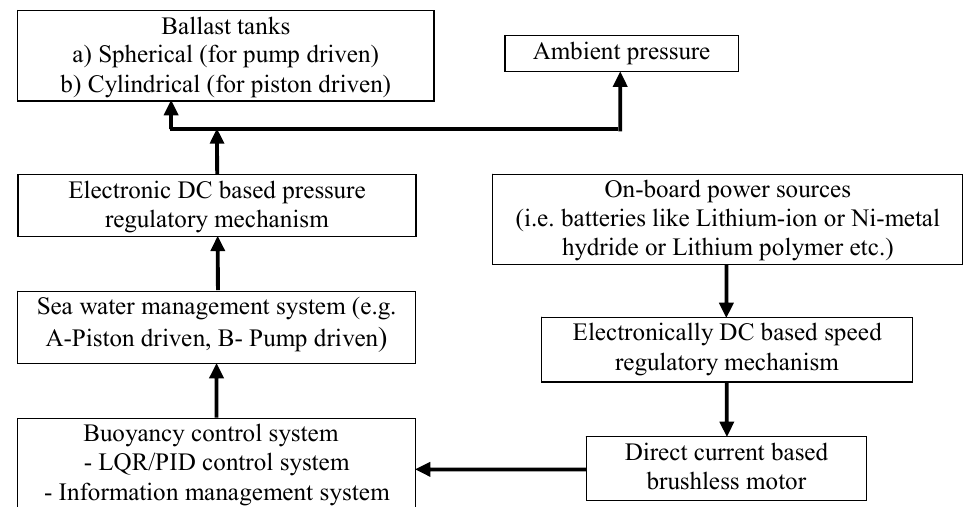
Figure 5. Our conceptual design approach of pump-driven VBS.